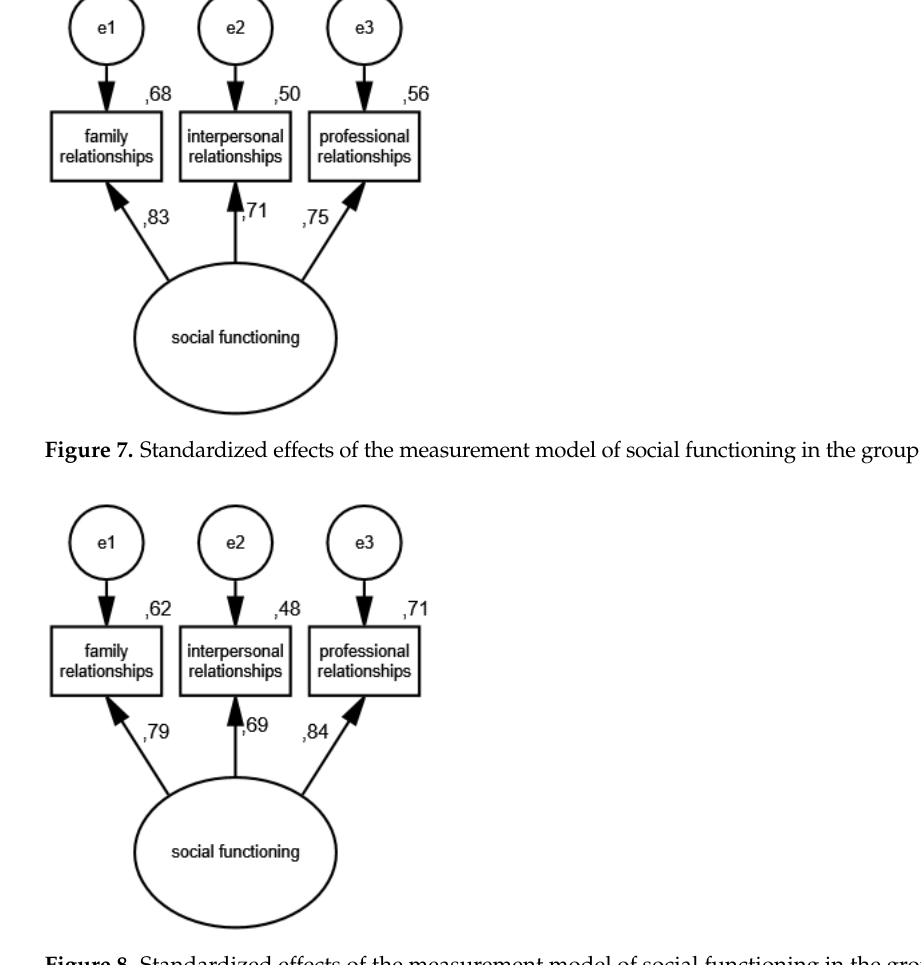
Figure 8. Standardized effects of the measurement model of social functioning in the group of men .